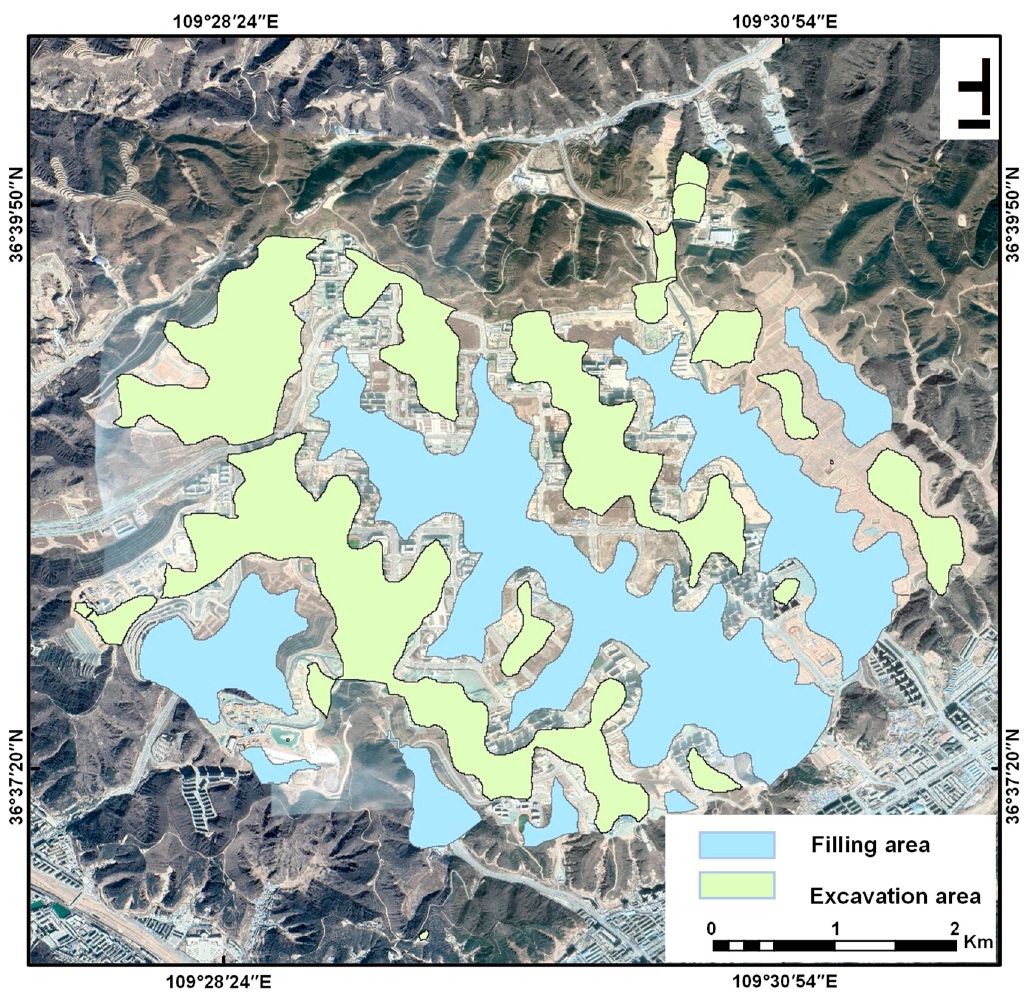
Figure 2. Distribution of valley filling and mountain excavation in Yan’an new district (YND) superimposed on the Google Earth image. The blue and yellow regions represent filling and excavating areas, respectively.